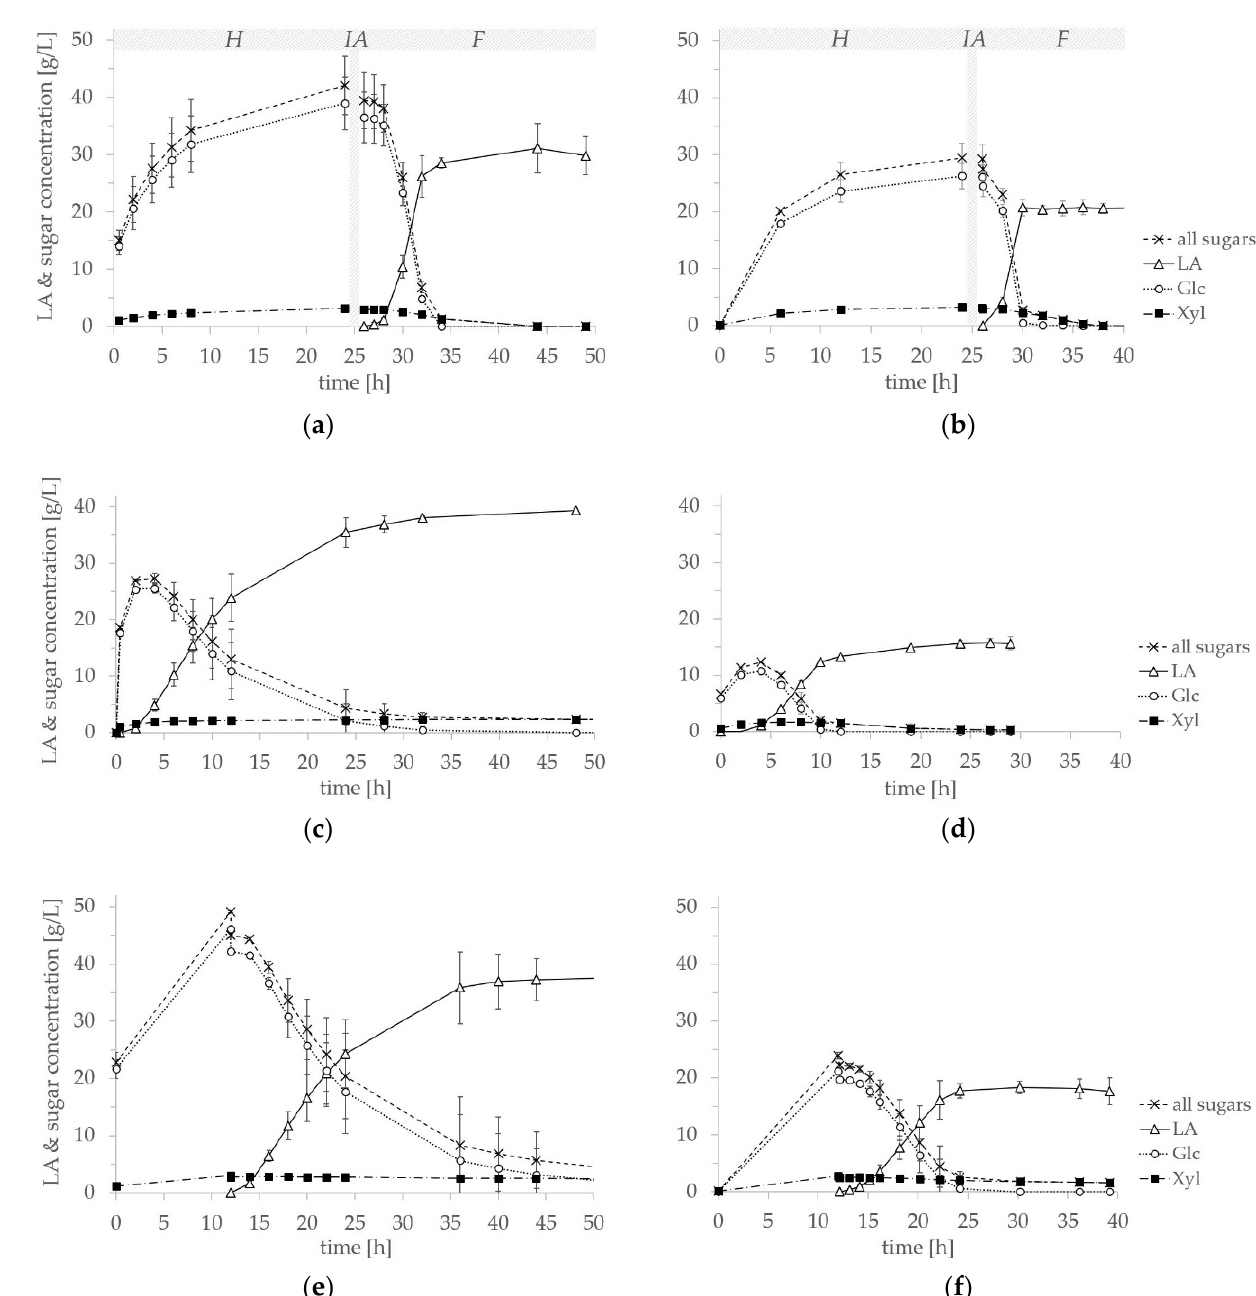
Figure 3. Separate and simultaneous fermentation experiments ( B. coagulans 14-300, 1 L working volume, 10 g L − 1 YE): ( a ) SHF of RS-LX and ( b ) SHF of DCS-LX, enzymatic hydrolysis ( H ) at 50 °C and pH 5, enzyme inactivation ( IA ) at 85 °C, fermentation ( F ) at 52 °C and pH 6; ( c ) SSF of RS-LX and ( d ) SSF of DCS-LX at 50 °C and pH 5; ( e ) PSSF of RS-LX and ( f ) PSSF of DCS-LX at 50 °C and pH 5.